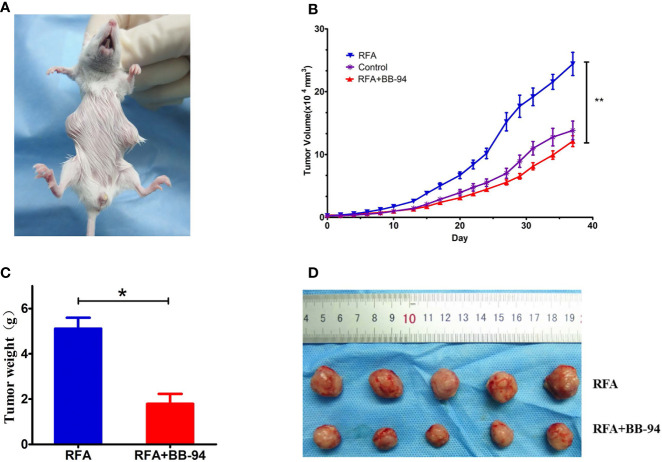
Comparison of tumor metastasis. (A) The paired tumors model was used in this phase. One tumor was performed with RFA and the second tumor in other site was regarded as the metastasis tumor. (B) The tumor growth curves of other site of tumors at different treatment groups. (C) Quantitative analysis of the other site of the tumor weight in the RFA group and the BB-94+RFA group 20 days after RFA. (D) The other site of tumors in the RFA group and the BB-94+RFA group 20 days after RFA. *P < 0.05, **P < 0.01.